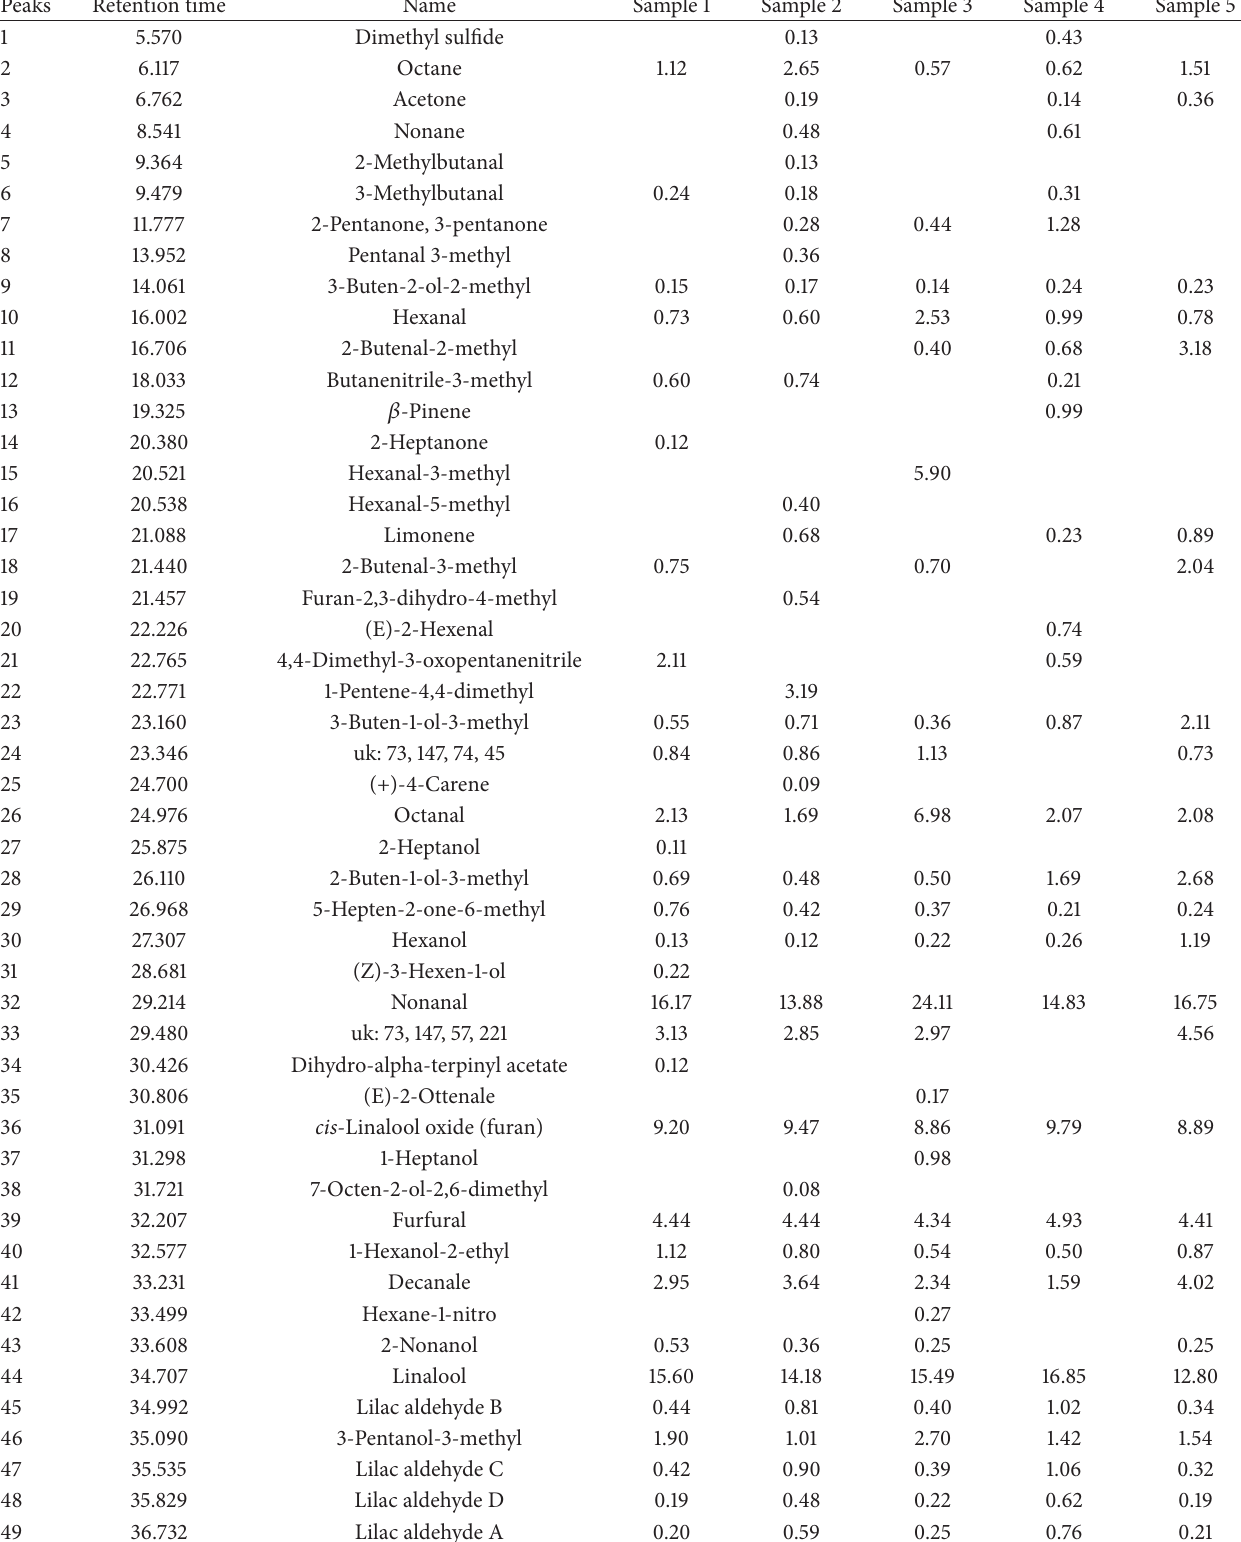
Table1:SPME-GC/MSanalysesoffivesamplesofblacklocusthoneys.SampleshavedifferentgeographicaloriginsalongtheItalianPeninsula, but their botanical origin was assessed by melissopalinological and sensory analyses before proceeding with volatile